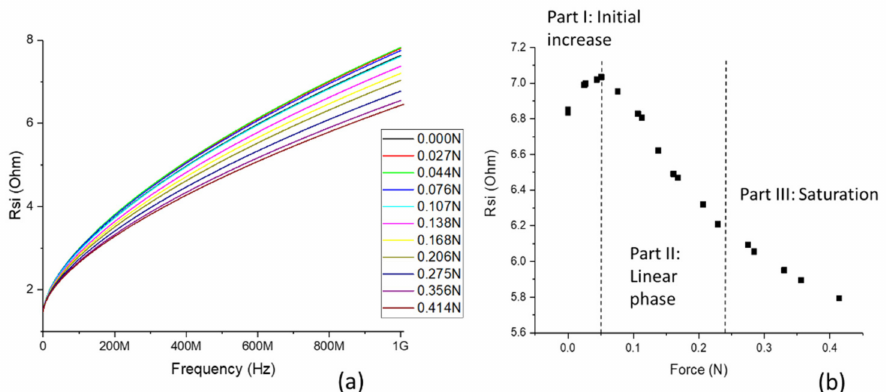
Figure 15. ( a ) Extracted R SI of the force sensor vs. frequency at different force loads. ( b ) R SI vs. applied force at 800 MHz measurement frequency.